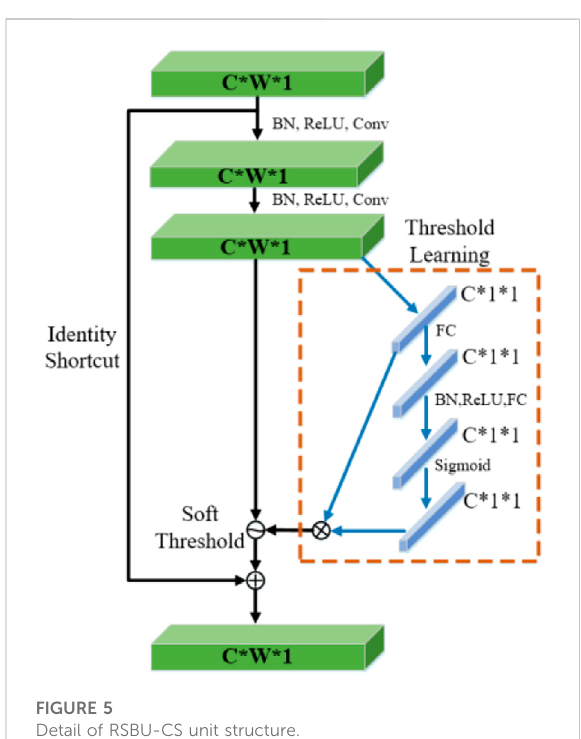
FIGURE 5 Detail of RSBU-CS unit structure.